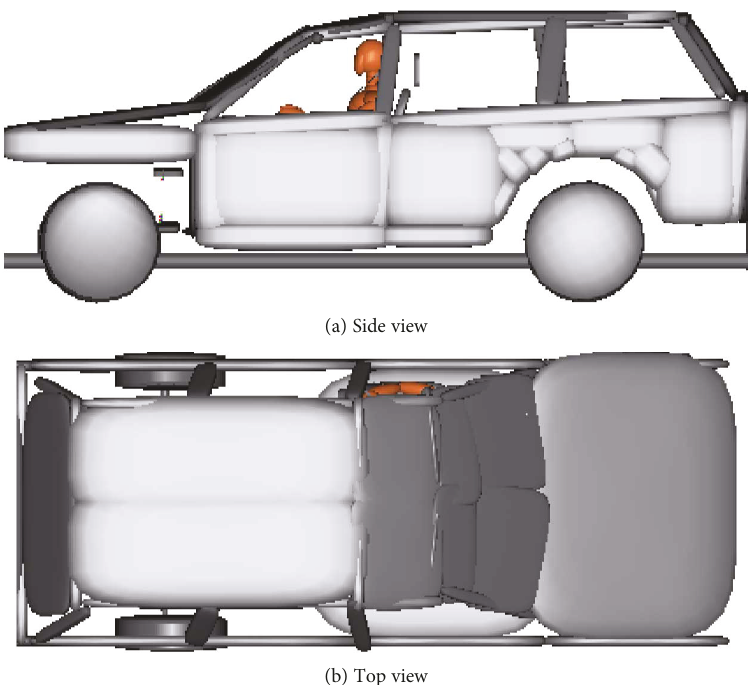
Figure 2: Rollover simulation model with Hybrid III dummy